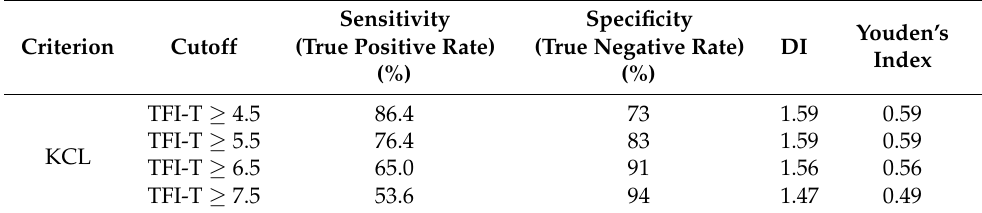
Table 3. The best cutoff point for the TFI-T based on Youden’s index.